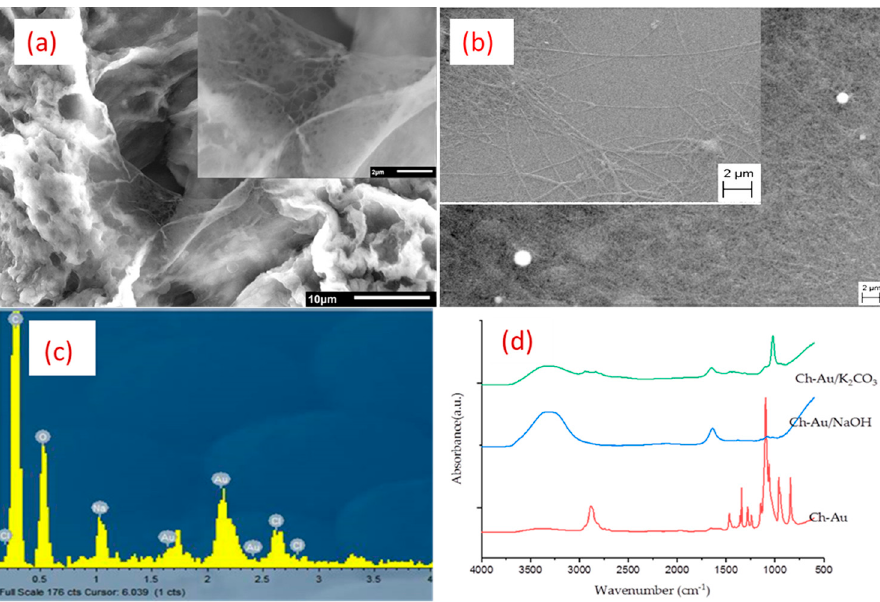
Figure 4. SEM micrograph of AuNPs-functionalized Chitosan (PEO) nanofibers neutralized: ( a ) with 1M K 2 CO 3 in 70% ethanol; ( b ) with 5M NaOH in methanol; ( c ) corresponding EDX spectroscopy graph showing presence of AuNPs after neutralizing with NaOH method; ( d ) FTIR spectra of nanofibers functionalized with AuNPs before neutralization (Ch-Au) and after neutralization with K 2 CO 3 (Ch-Au/K 2 CO 3 ) or NaOH (Ch-Au/NaOH). Adapted from Ref. [132]. Felipe et al. had also electrospun chitosan using PEO as co-spinning agent. The nan- ofibers were functionalized with carboxymethyl-hexanoyl chitosan/dodecyl sulphate na- noparticles loaded with pyrazoline H 3 TMO 4 for skin cancer treatment [133]. Polymers